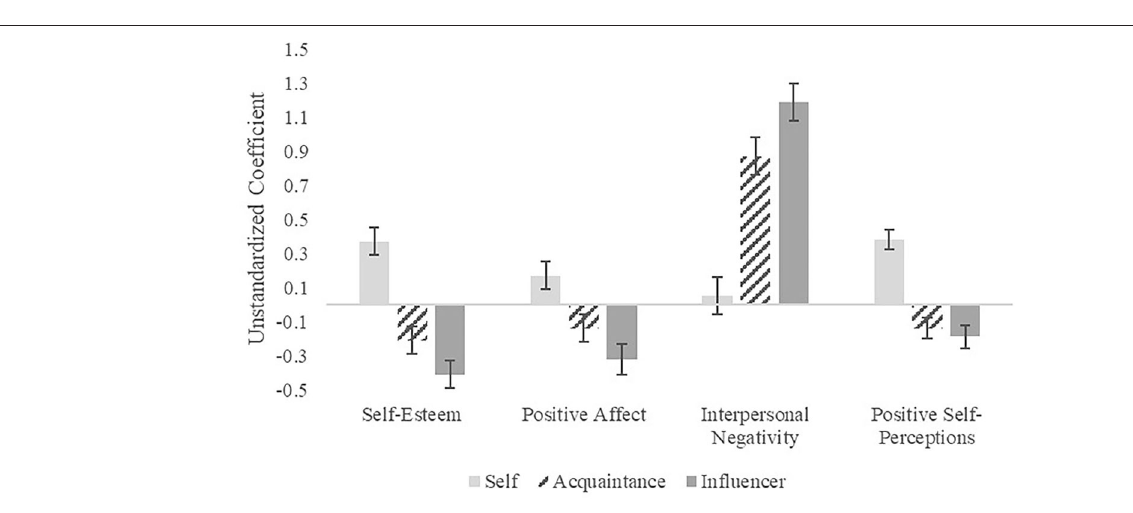
for negative affect ( p = 0.762); thus, negative affect was